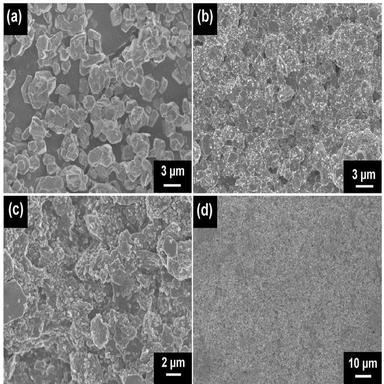
SEM images of P2-MCC (a) powder material, (b) electrode; (c) and (d) electrode after 100 cycles at 200 mA g1 .